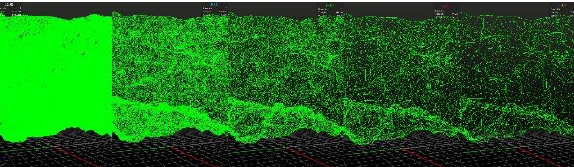
Figure 9. LODs visualization. Triangular meshes per LOD. From left to right: the full-resolution model to the simplified